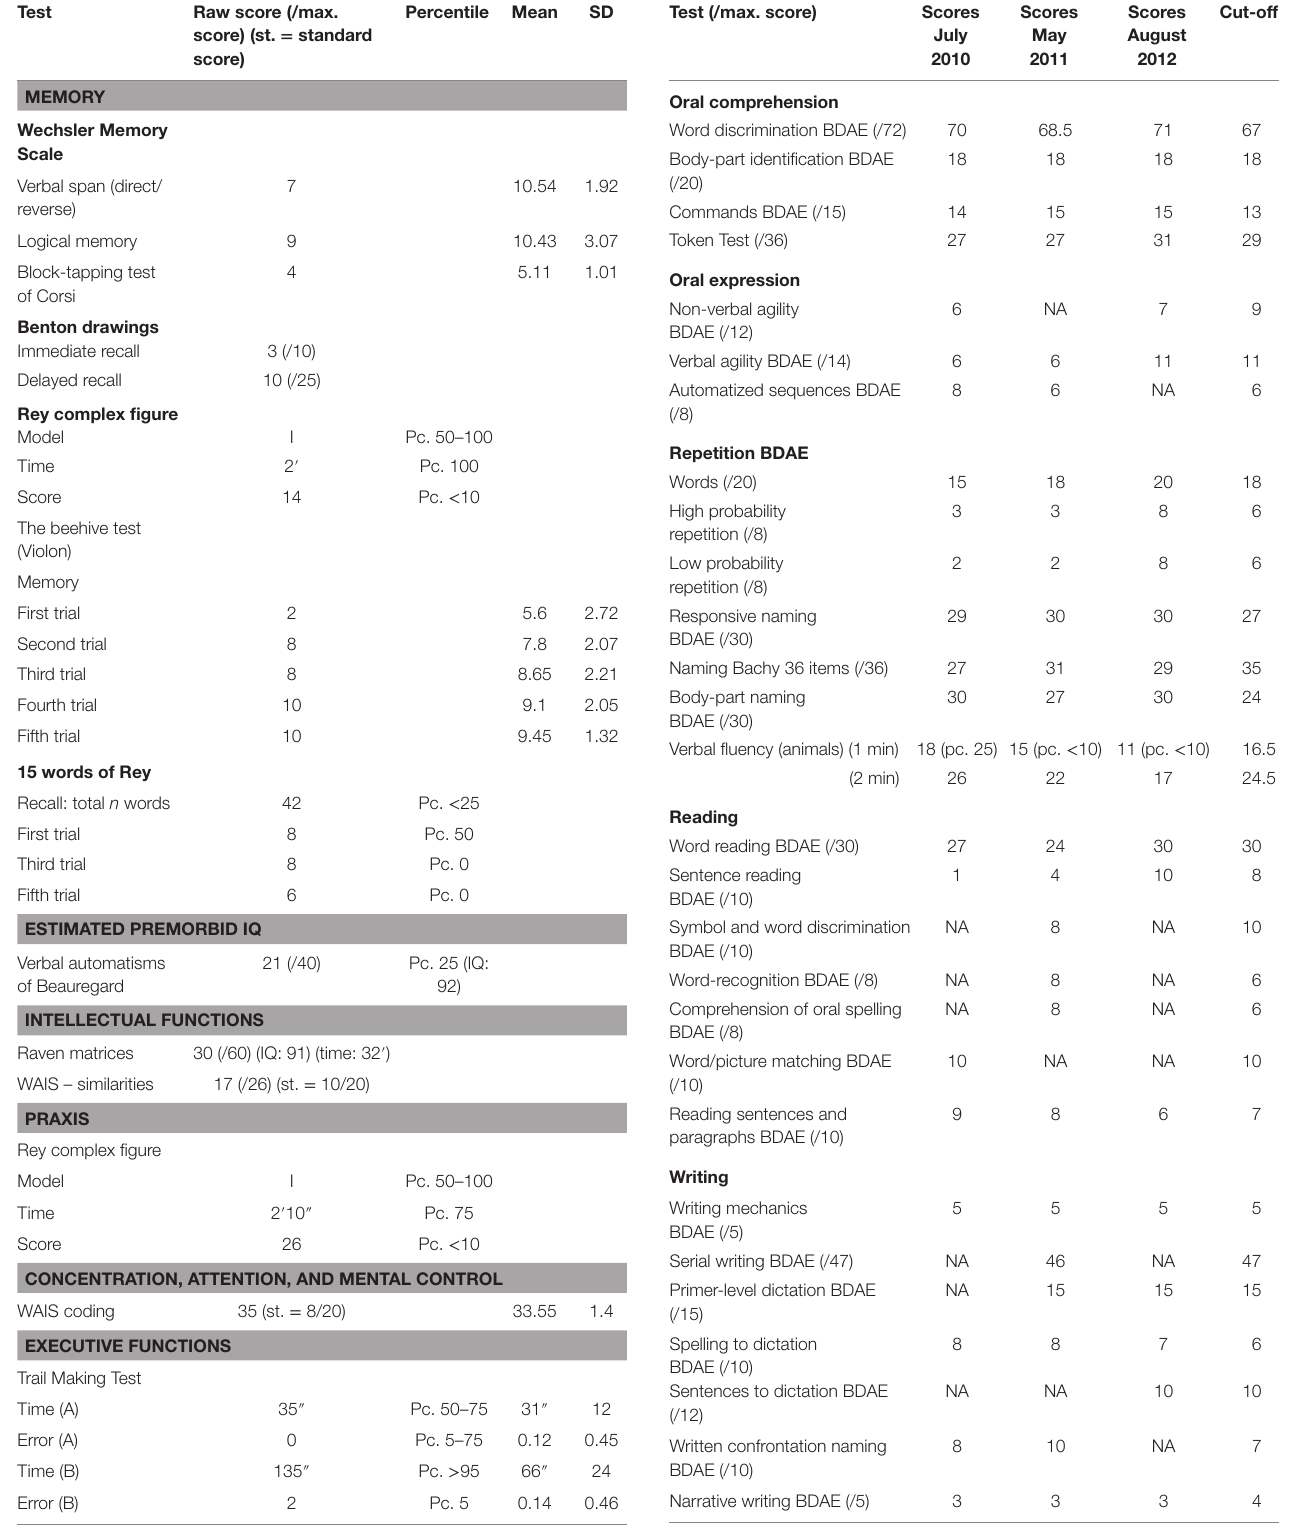
taBLe 4 | Neurolinguistic test results. taBLe 3 | Neuropsychological test results (september